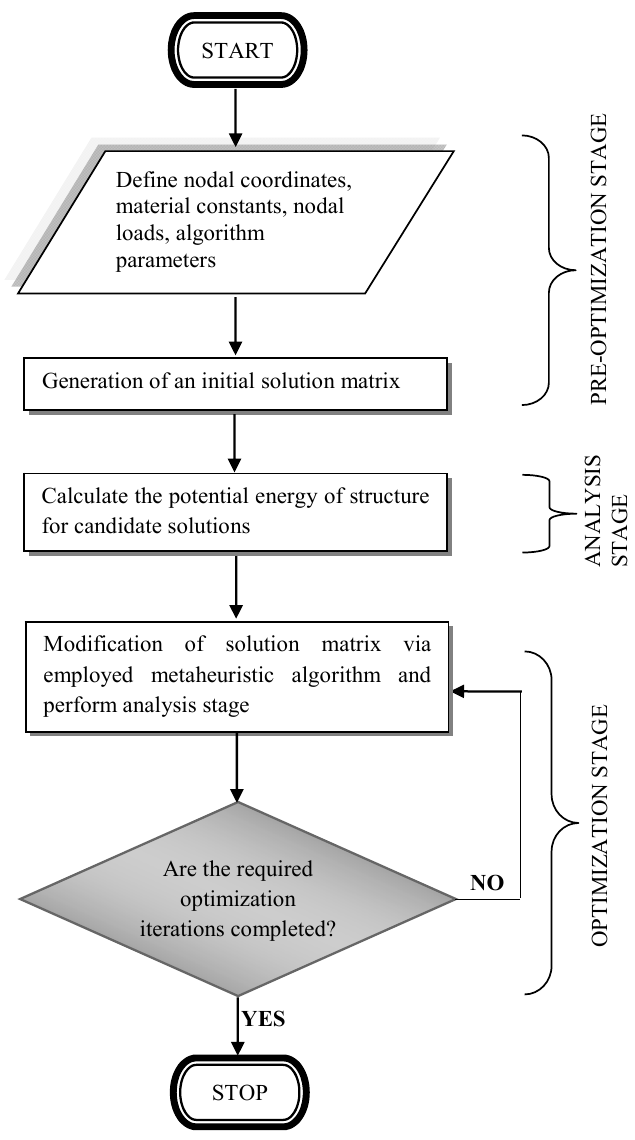
Figure 2. The flowchart of the Total Potential Optimization using Metaheuristic Algorithms (TPO/MA) including three stages used in the process.